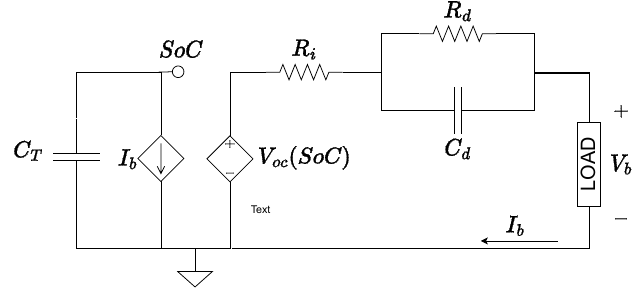
Figure 4. Equivalent circuit model with a single time constant for